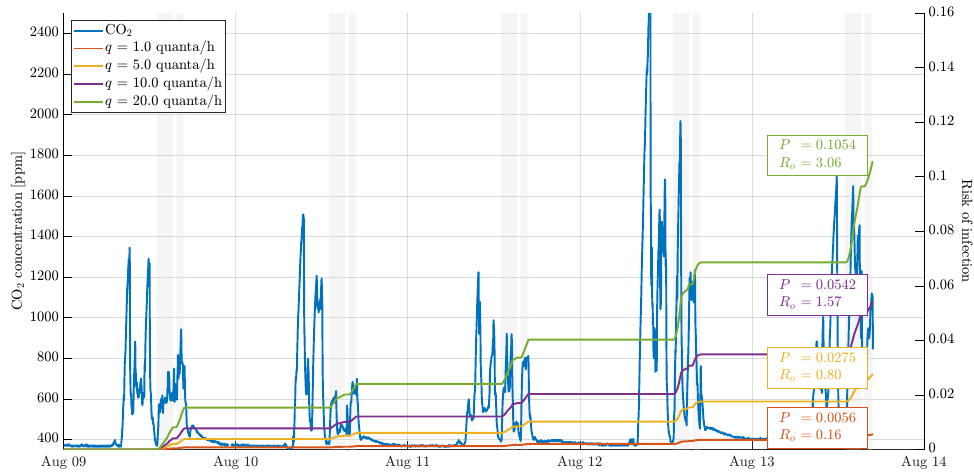
Figure 10. Risk results from a weekly measurement in August, for the afternoon shift. CO 2 mea- surements and the evolution of the probability of infection for different quanta generation rates are shown. The grey shaded background identifies occupation time for the afternoon shift. The coloured boxes detail the probability of infection and the basic reproduction number by the end of the week. Table 4. Weekly estimation of the basic reproduction number for different quanta emission rates. Weekly Estimation of R o Morning shift q